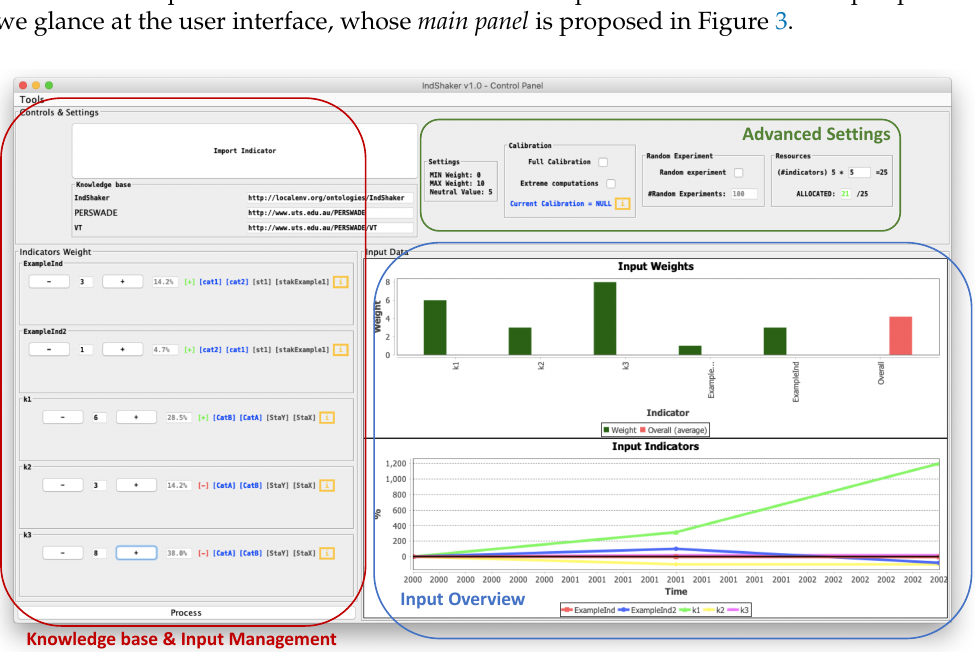
Figure 3. GUI—main